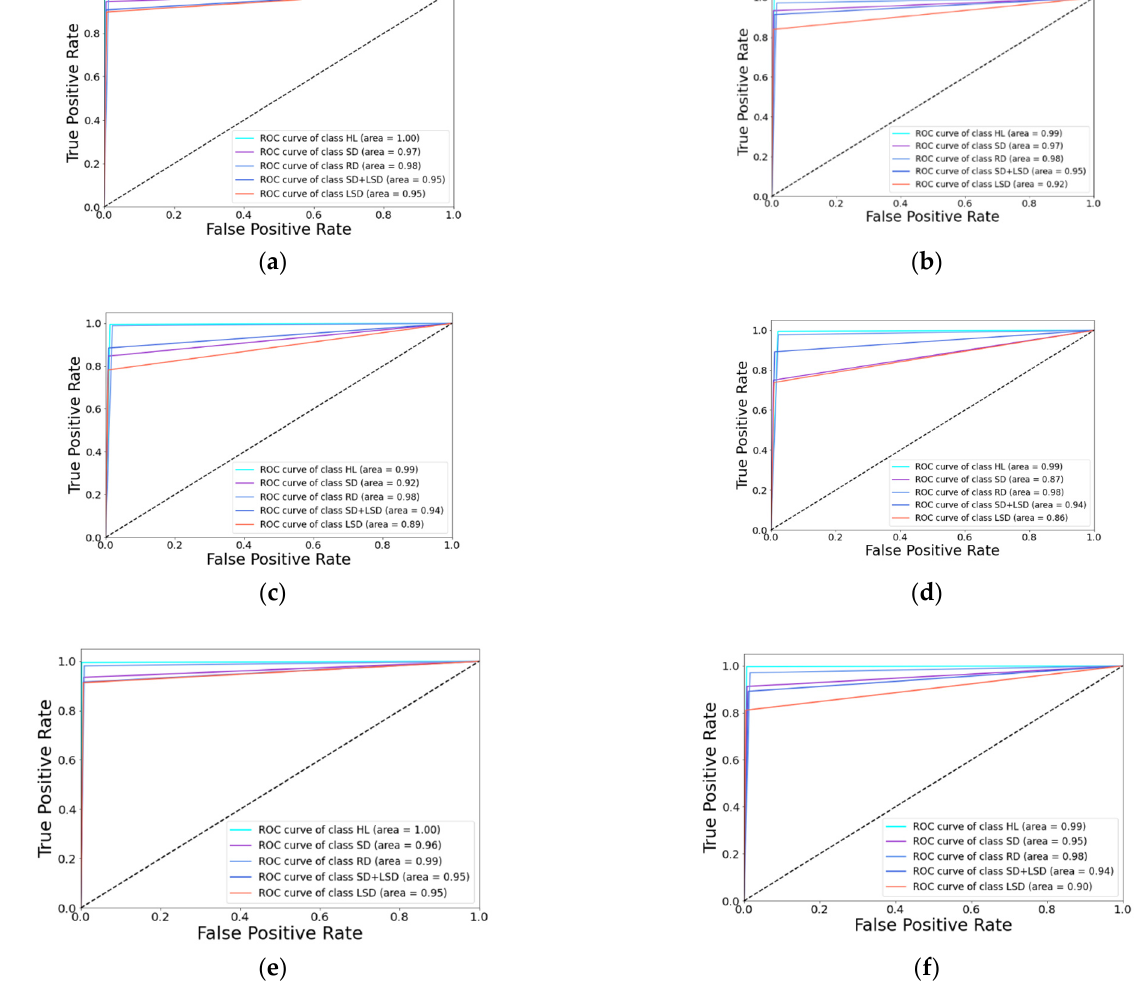
Figure 7. ROC curves for the model after ensemble. ( a ) ROC curve DenseNet121 + LR data augmentation; ( b ) ROC curve DenseNet121 + LR without data augmentation; ( c ) ROC curve VGG16 + SVM data augmentation; ( d ) ROC curve VGG16 + SVM without data augmentation; ( e ) ROC curve DenseNet121 + RF data augmentation; ( f ) ROC curve DenseNet121 + RF without data